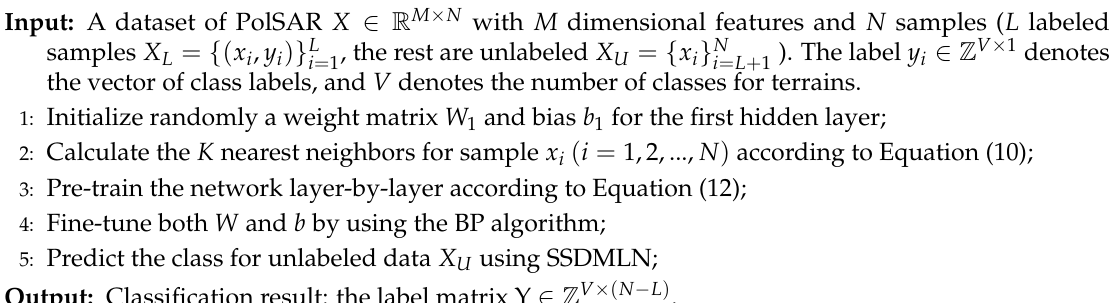
Algorithm 1 SSDMLN for classification of PolSAR